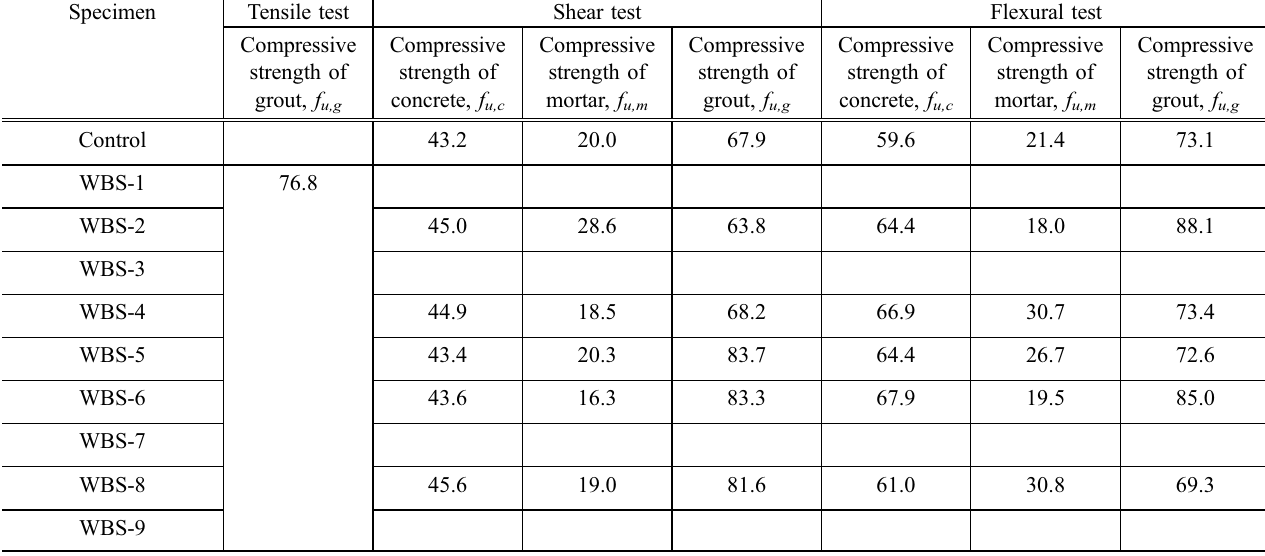
Table 4 Compressive strength of concrete, mortar and grout for each specimen (unit: N/mm 2 ).